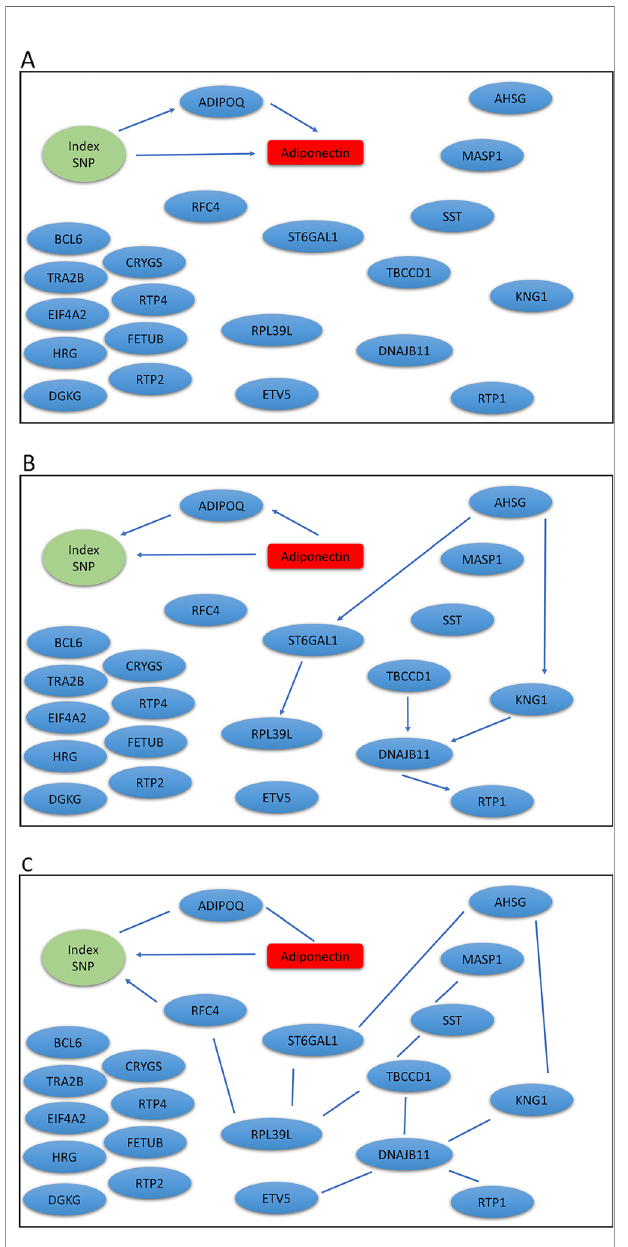
FIGURE 4 | Graphic results for causal network analysis of Metabolic Syndrome in Men dataset, a mixed type dataset consisting of a categorical variable, one index SNP at ARL15 GWAS locus, and continuous variables, including expression of 8 genes and adiponectin levels (disease trait). The arrows indicate direction of causality. (A) mDAG; (B) MMHC; (C)